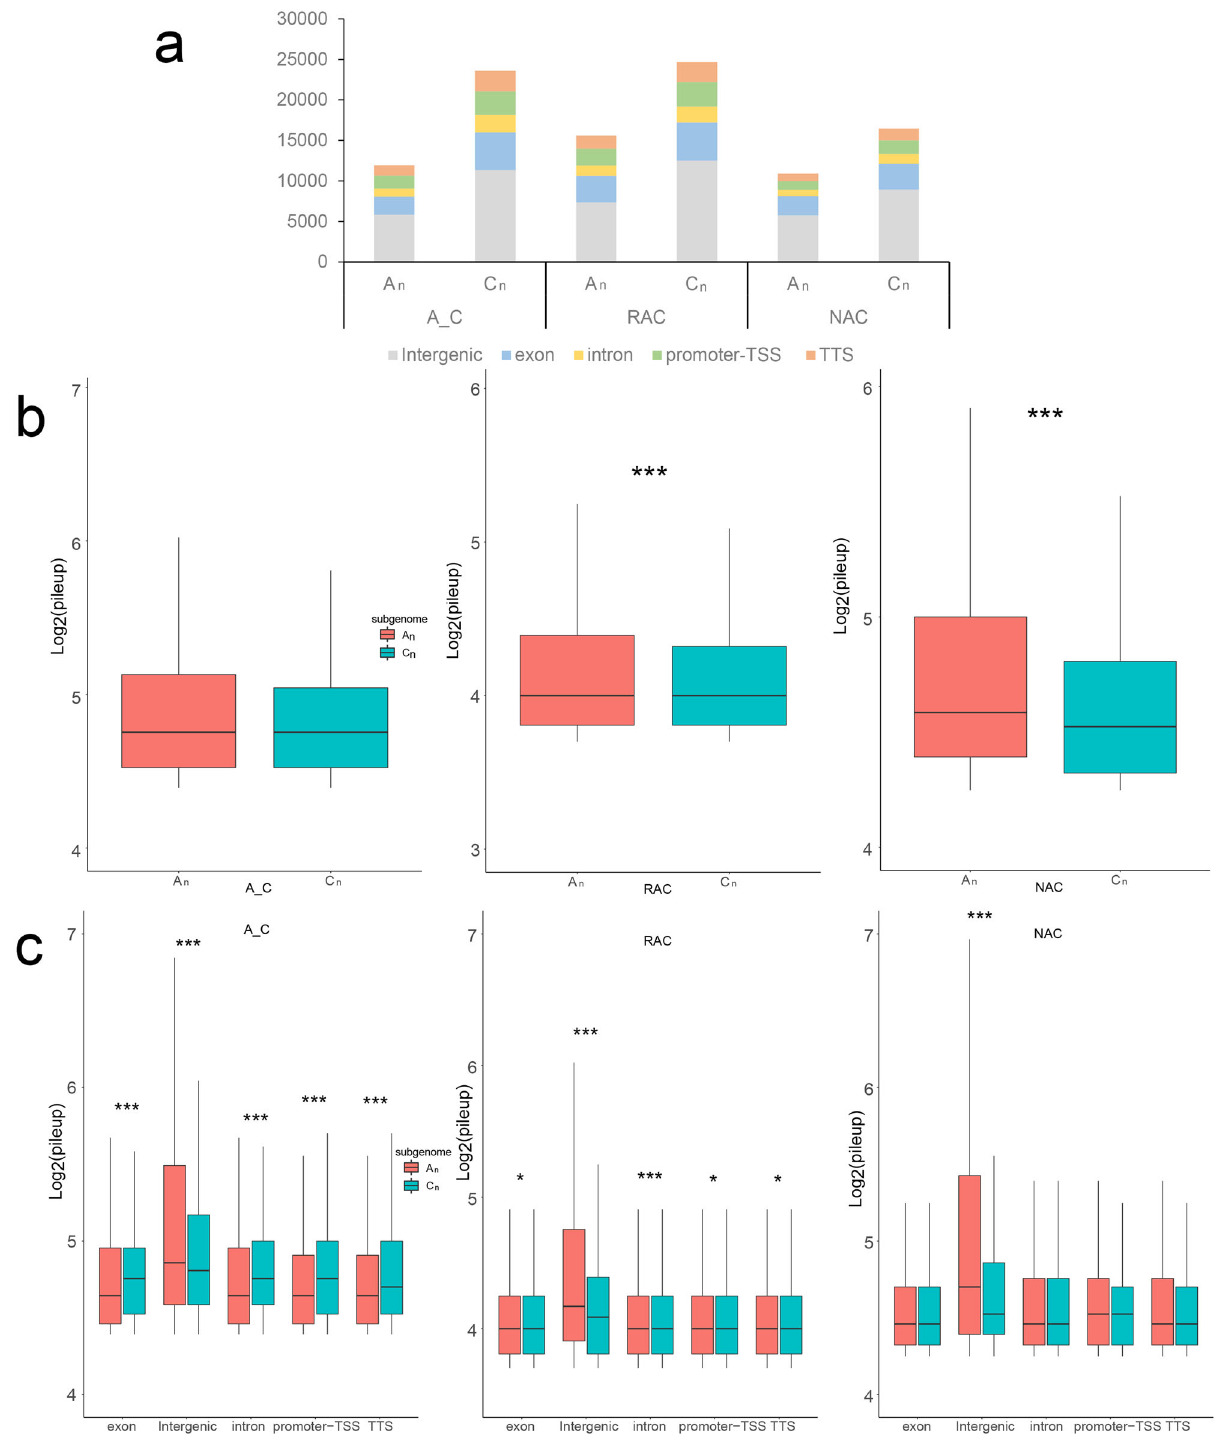
Fig. 7 Comparison of the chromatin accessibility between two subgenomes. a Number statistics of ACRs in genomic regions of two subgenomes. b Comparison of the intensity of ACRs between two subgenomes. c Comparison of the intensity of ACRs in genomic regions between two subgenomes. A_C, in silico ‘ hybrid ’ ; RAC, resynthesized B. napus ; NAC, natural B. napus ; pileup, the intensity of ACR. Statistical analysis was conducted using Wilcoxon rank sum test. * p < 0.05 and *** p <